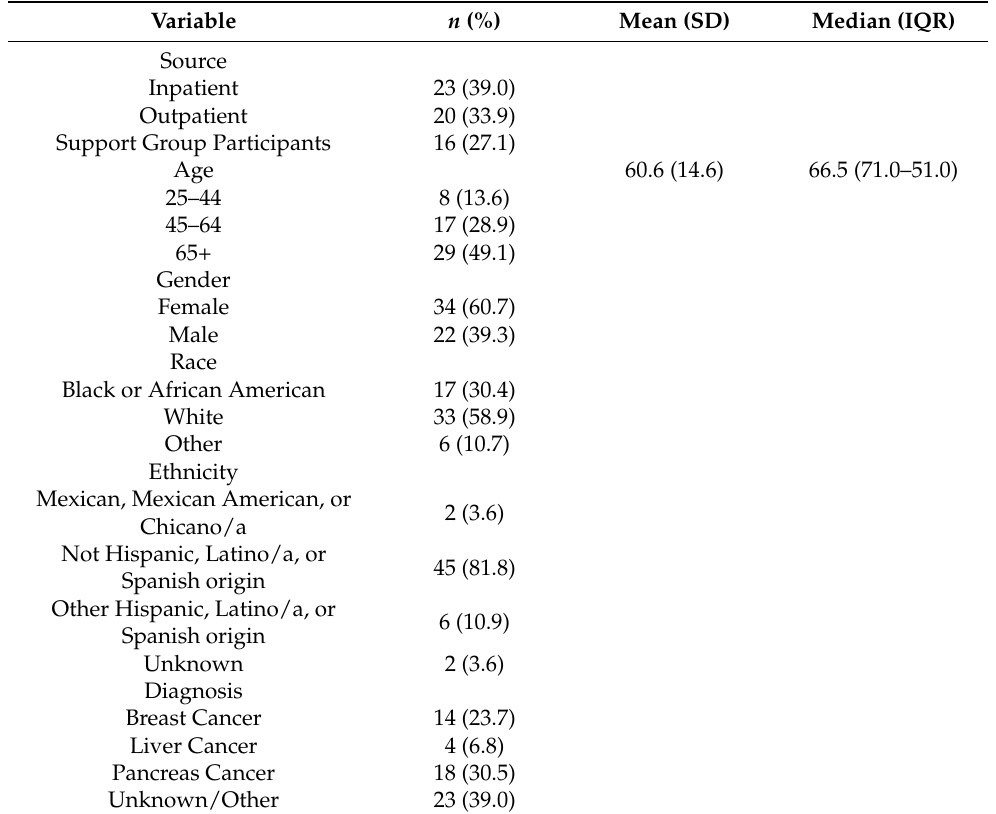
Table 2. Participant Demographics ( n = 59).